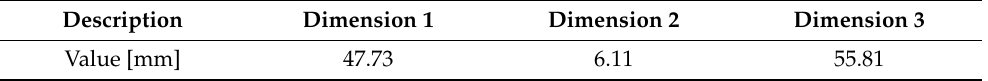
Figure 13. Deflection for the open lever with 0.2% shrinkage-rate constant applied. Table 22. Results of measurement 1, 2, 3 for the open lever with 0.2% shrinkage-rate constant ap- plied. Description Dimension 1 Dimension 2